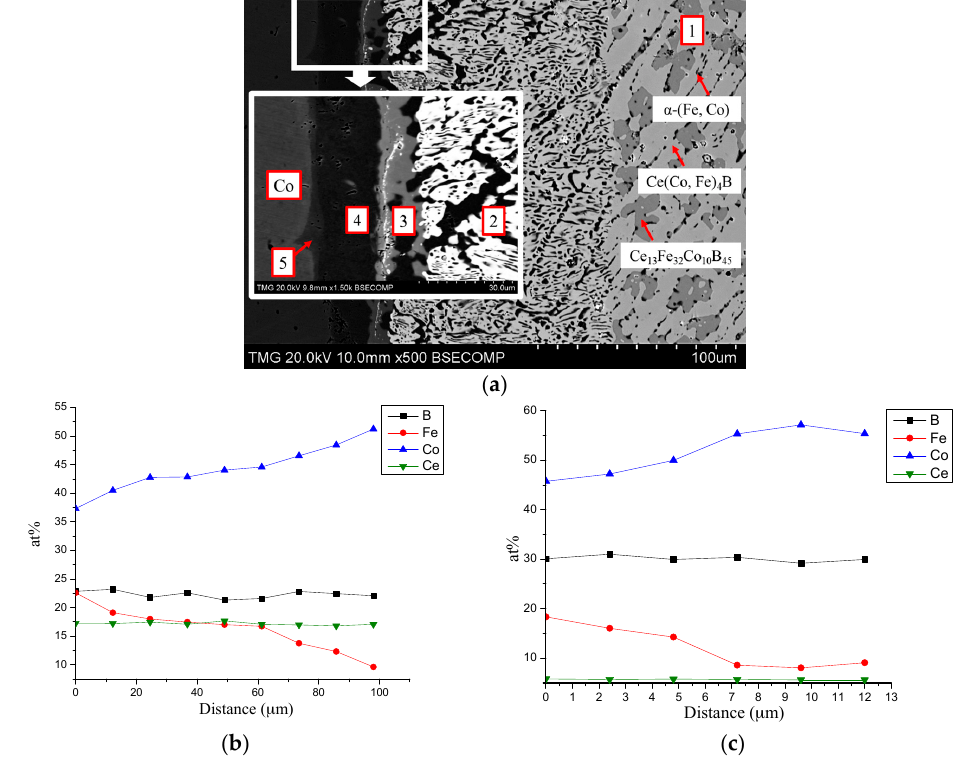
Figure 7. ( a ) BSE image of DC4; ( b ) WDS compositional profile of Ce 3 (Co, Fe) 11 B 4 in layer 2; ( c ) WDS compositional profile of Ce(Co, Fe) 12 B 6 in layer 3.